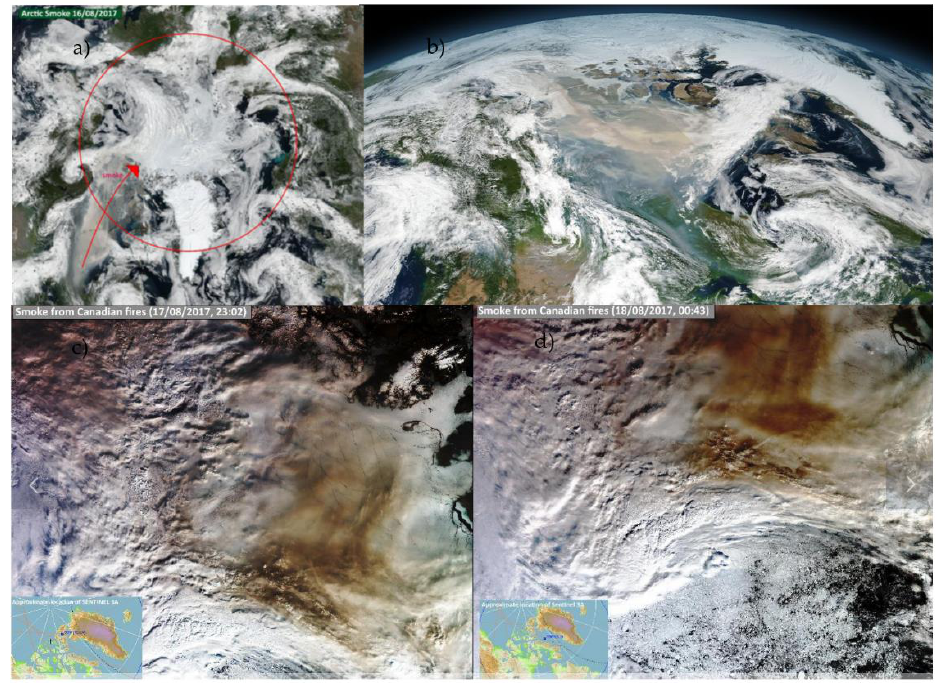
Figure 2. Smoke from the Canadian wildfires being transported towards the Arctic ( a ) VIIRS instrument on Suom-NPP on 16 August 2017, ( b ) VIIRS instrument on Suom-NPP on 15 August 2017, and ( c , d ) OLCI instrument on Sentinel 3 17–18 August 2017.